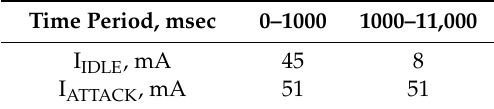
Table 6. The results of the XBee power consumption in normal mode and under